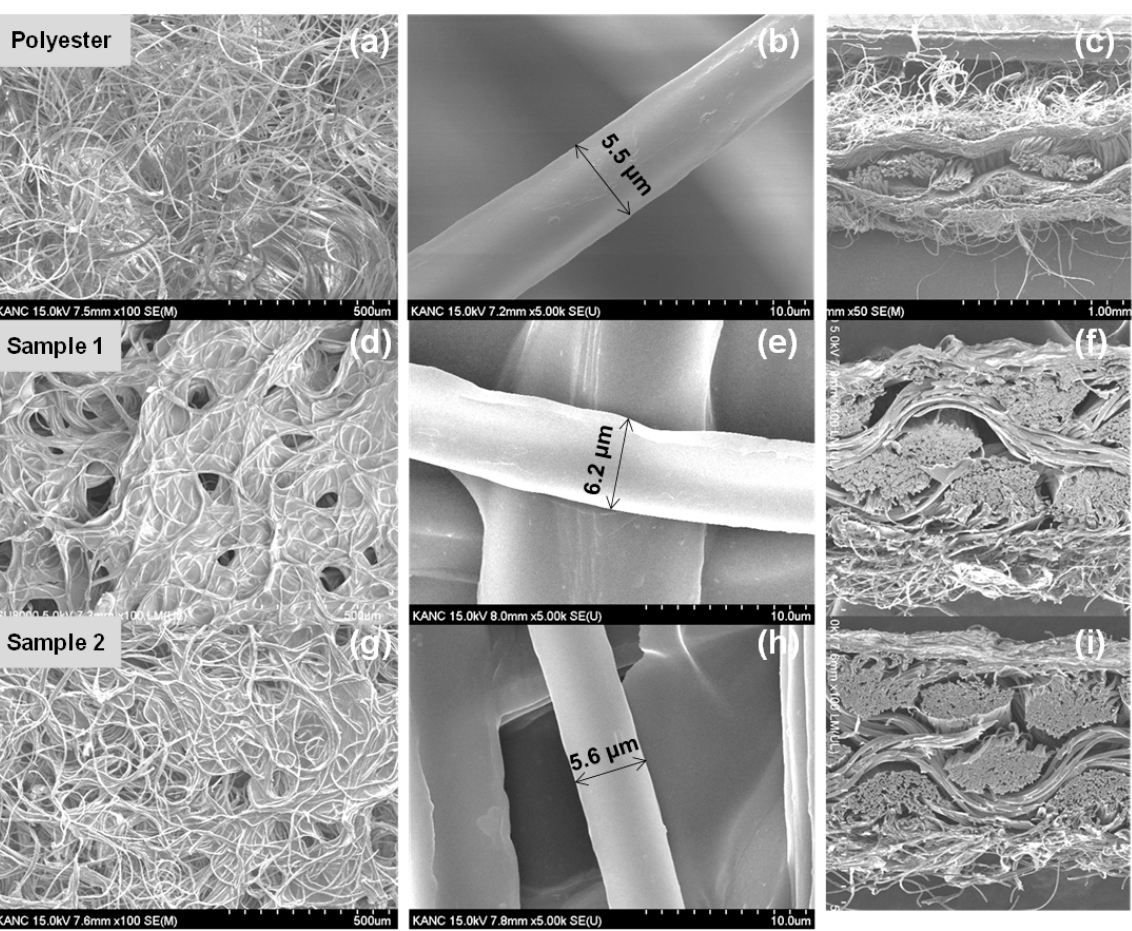
Figure 2. Scanning electron microscopy (SEM) images showing morphology of the pristine textile ( a – c ), sample 1 ( d – f ), and sample 2 ( g – i ) at low magnification ( a ), medium magnification ( b ) and ( c ) cross-sectional SEM images.